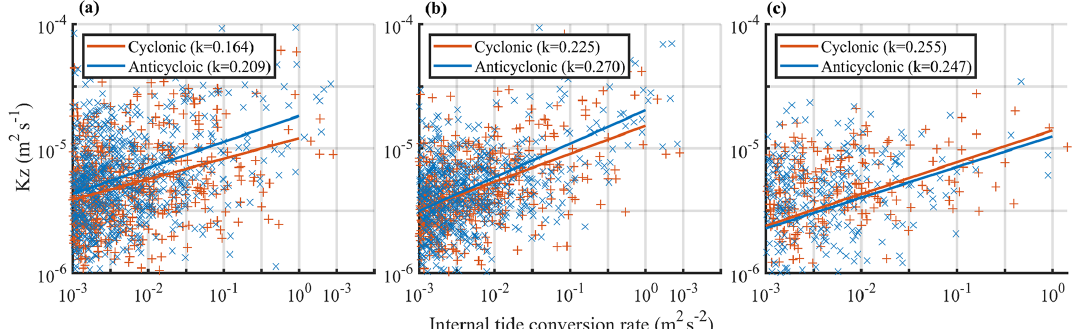
Figure 11. Scatterplot of log-scale K z versus log-scale internal tide conversion rate, with cyclone (red) and anticyclone (blue), at (a) 250– 500m, (b) 500–1000m, and (c) 1000–1500m. The best fit slopes are denoted by the red and blue solid